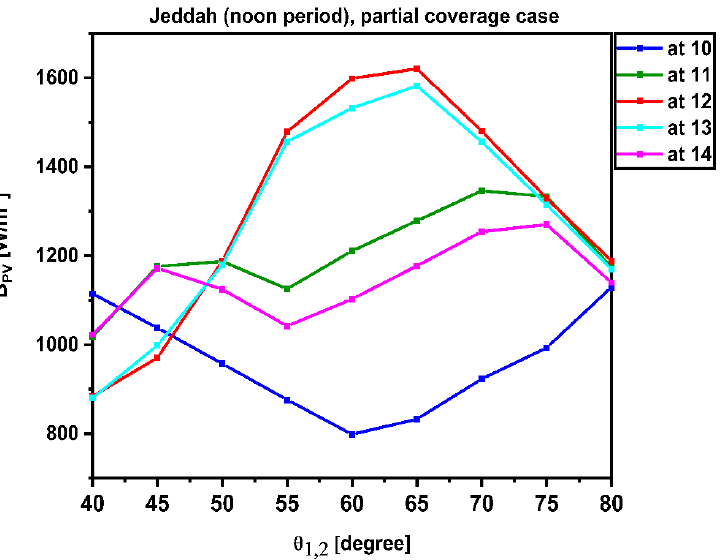
Figure 6. The irradiance B PV at different inclination angles in the case of partial coverage for the solar time from 10:00 to 14:00 ( θ 1 = θ 2 ) for